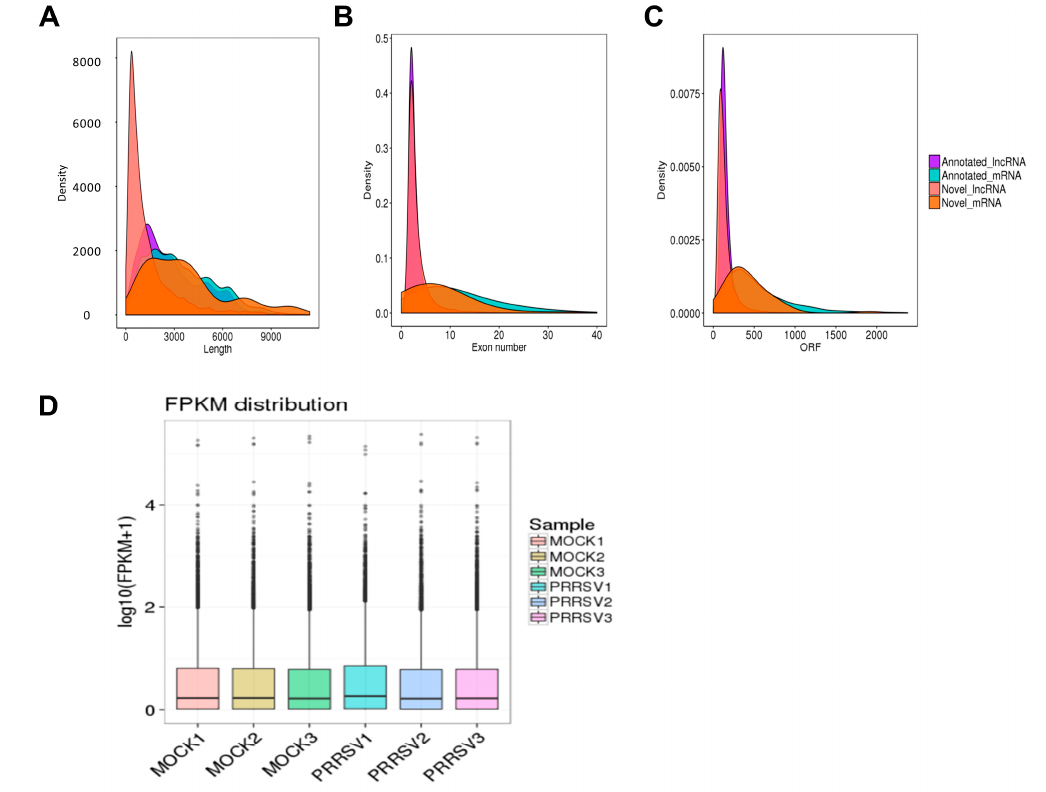
Figure 2. The RNA sequencing and lncRNA identification. ( A ) lncRNA and mRNA length com- parison density distribution map. ( B ) Exon number density distributions of lncRNA and mRNA. ( C ) ORF length density distributions of lncRNA and mRNA. ( D ) Boxplots demonstrating the expression levels of lncRNAs and mRNAs in each sample.